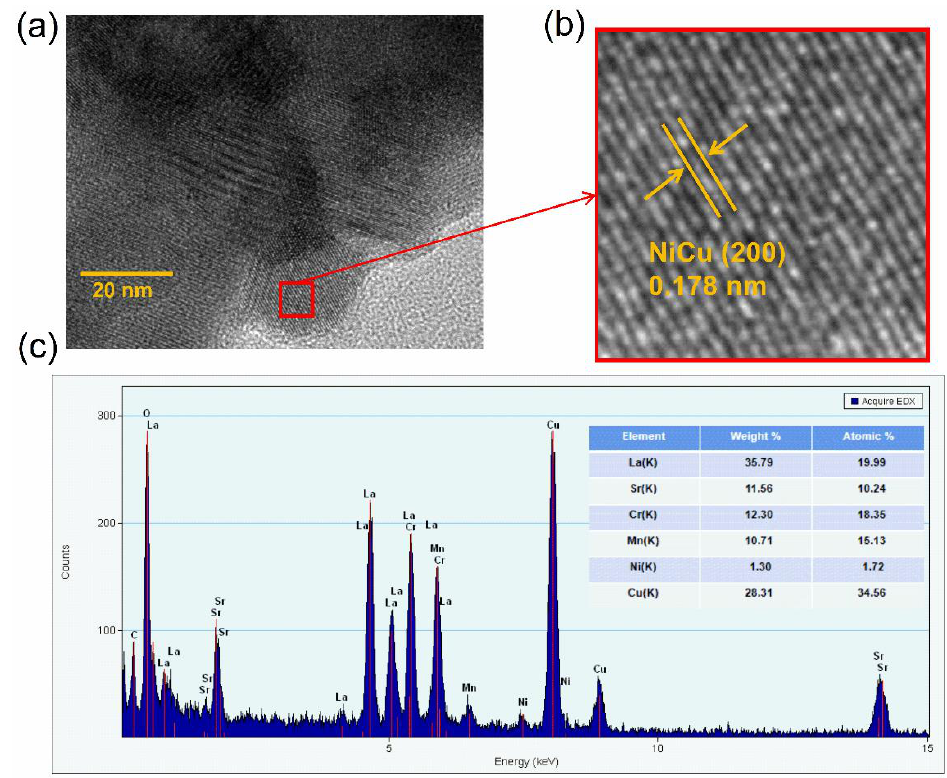
Figure 4. HRTEM with element dispersive X − ray spectroscopy analysis. ( a ) HRTEM image of reduced LSCrM(NC) x and lattice spacing micro − image of the exsolved ( b ) NiCu alloy, and ( c ) EDS analysis of the corresponding regions.